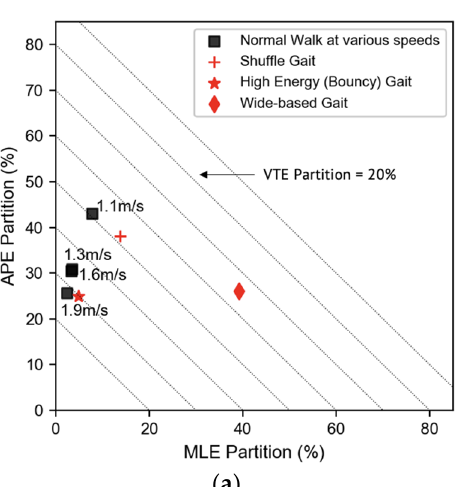
Figure 4. ( a ) TOE versus OEP based on the single individual from Figure 3. ( b ) TOE versus OEP of 47 subjects; 4 of the 9 participants who reported underlying health conditions are highlighted.